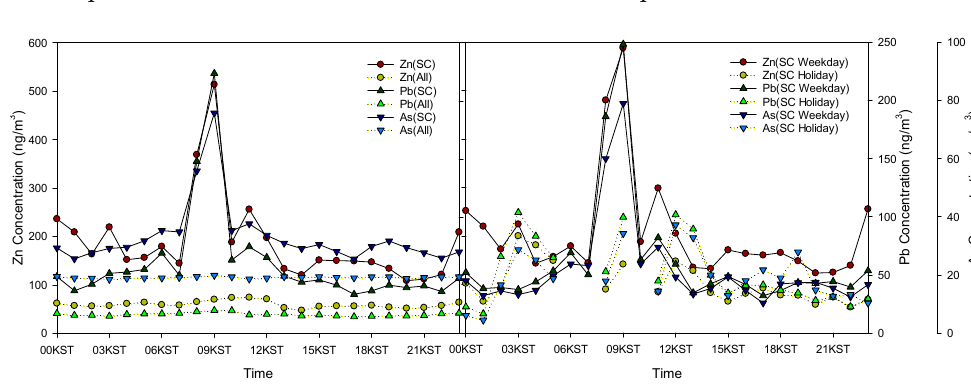
Figure 12. Diurnal changes in zinc (Zn), lead (Pb), and arsenic (As) concentrations ( left : diurnal changes of ALL and SCs) ( right : diurnal changes of weekdays and holidays (including weekends) in SCs).